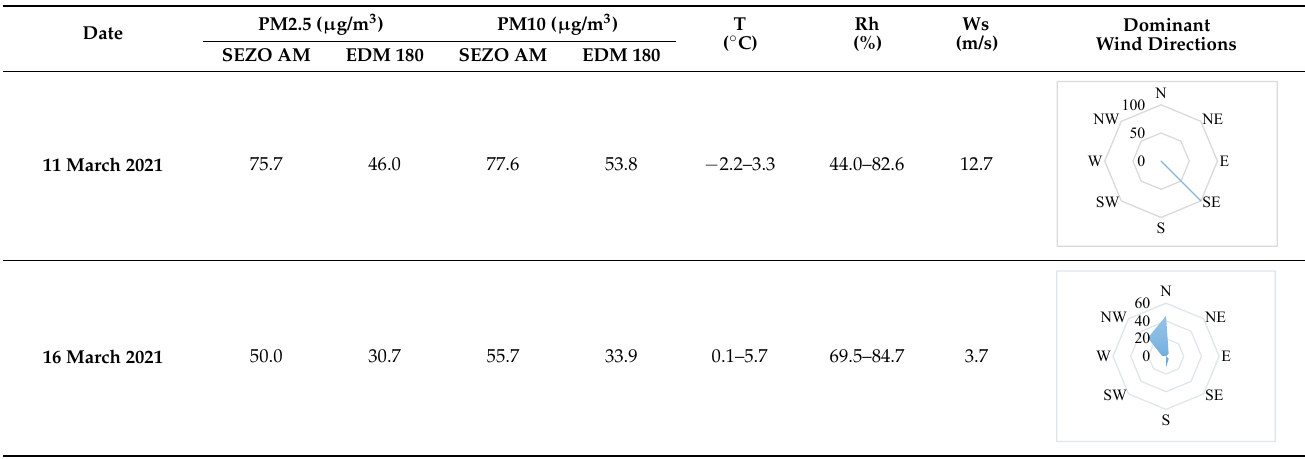
Table A1. Outliers concentrations o PM2.5 and PM10 obtained with SEZO AM and EDM 180 methods which were rejected with the corresponding weather